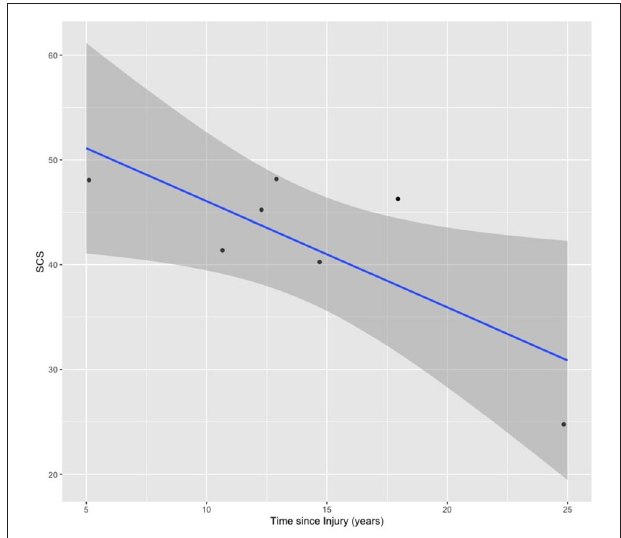
FIGURE 5 | Negative correlation between Time since Injury (years) and SCS